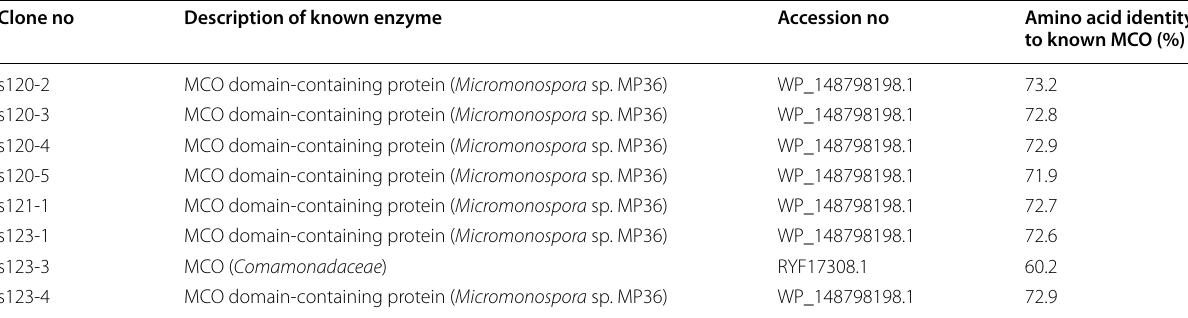
Table 2 BLAST analysis of MCO core gene DNAs isolated from metagenomes Clone no Description of known enzyme